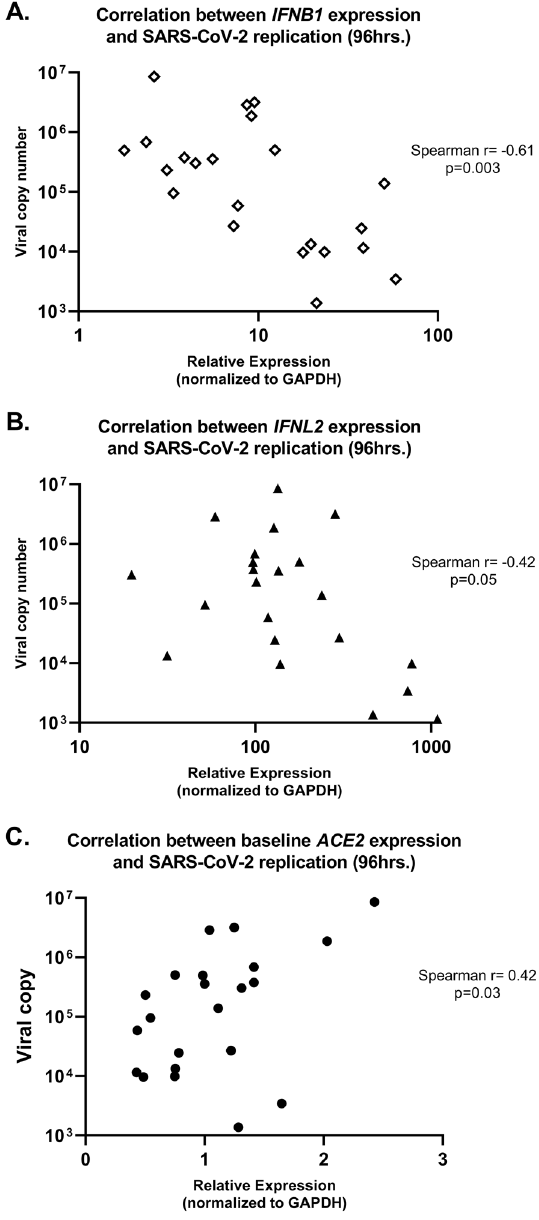
Figure 4. Correlation between relative gene expression of IFNB1 , IFNL2, and ACE2 (normalized to GAPDH) and SARS-CoV-2 WA-01 viral replication by quantitative PCR in primary bronchial epithelial cell cultures in children (n = 14) and adults (n = 8). IFNB1 and IFNL2 gene expression were inversely correlated with SARS- CoV-2 replication [( A ) Spearman r = − 0.61, p = 0.003; ( B ) Spearman r = − 0.42, p = 0.05). ACE2 gene expression in parallel uninfected AEC cultures was positively correlated with SARS-CoV-2 replication in WA-01 infected cultures [( C ) Spearman r = 0.42, p =